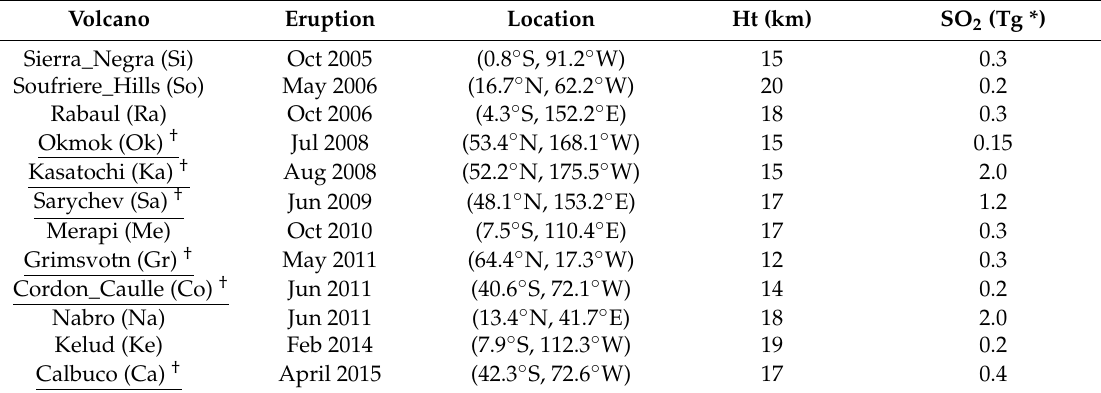
Table 1. Volcano eruptions with significant SO 2 injection into the stratosphere ‡